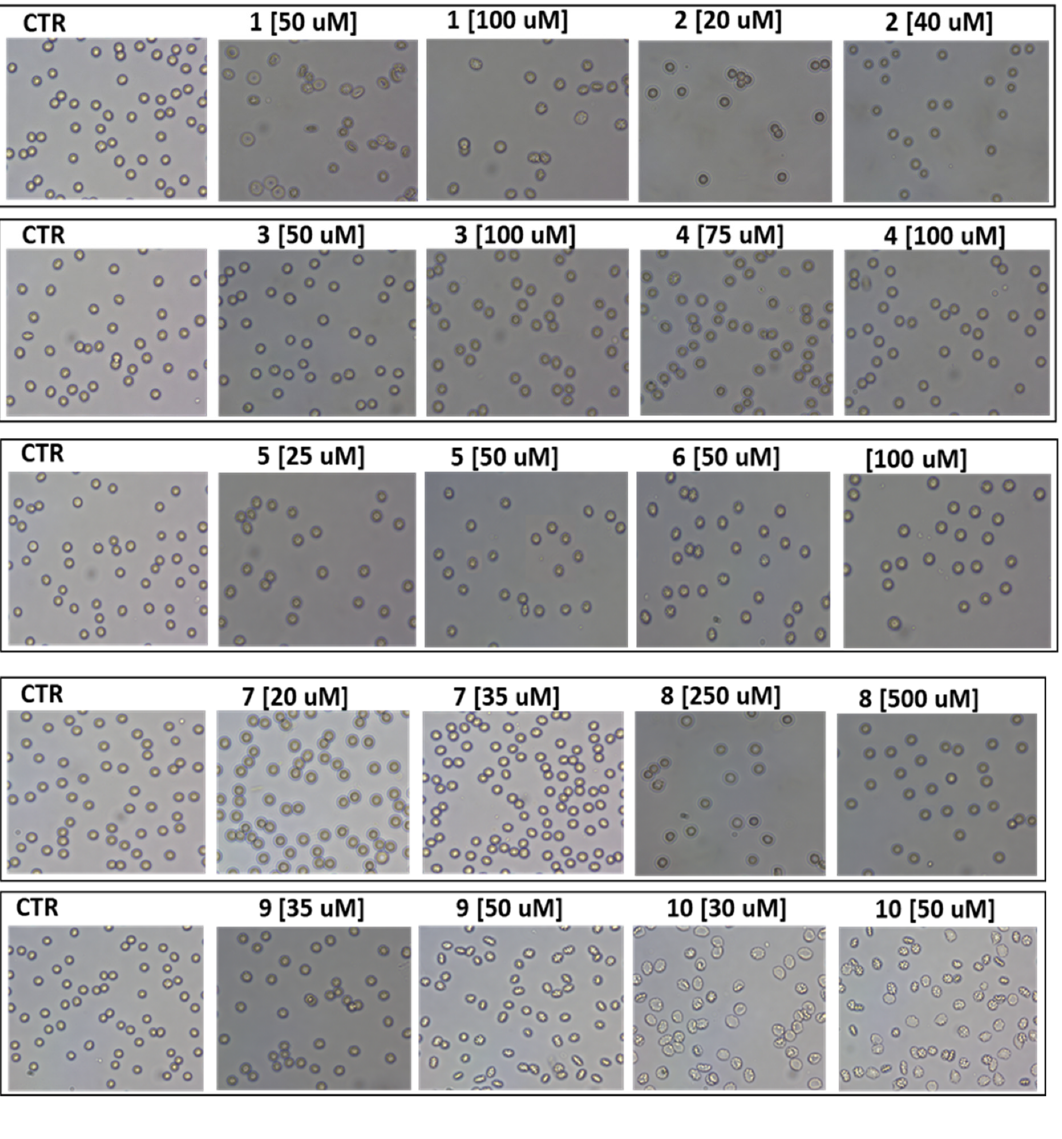
Figure 6. Microscope images of erythrocytes treated with ( A )—reference compounds, chromanone and flavanone; ( B )—compounds 1 , 2 , 3 , 4 , 5 , 6 , 7 , 8 , 9 , 10 . 2% erythrocyte suspension was treated at 37 ºC for 60 min with indicated concentrations of compound. Representative phase-contrast images are shown (magnification of 400 times).